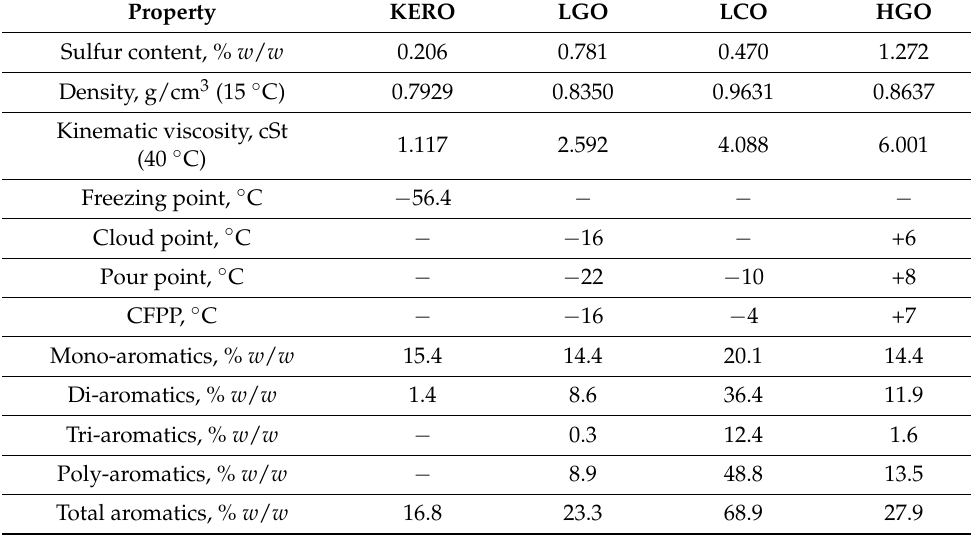
Table 1. Properties of the petroleum middle distillates